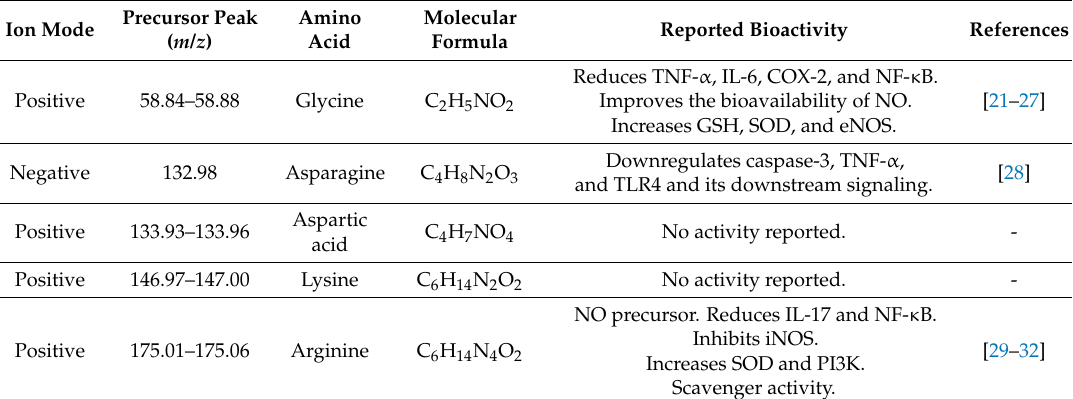
Table 1. Amino acids identified in the subfractions SF1 and SF3 from Cucumis sativus aqueous fraction by mass